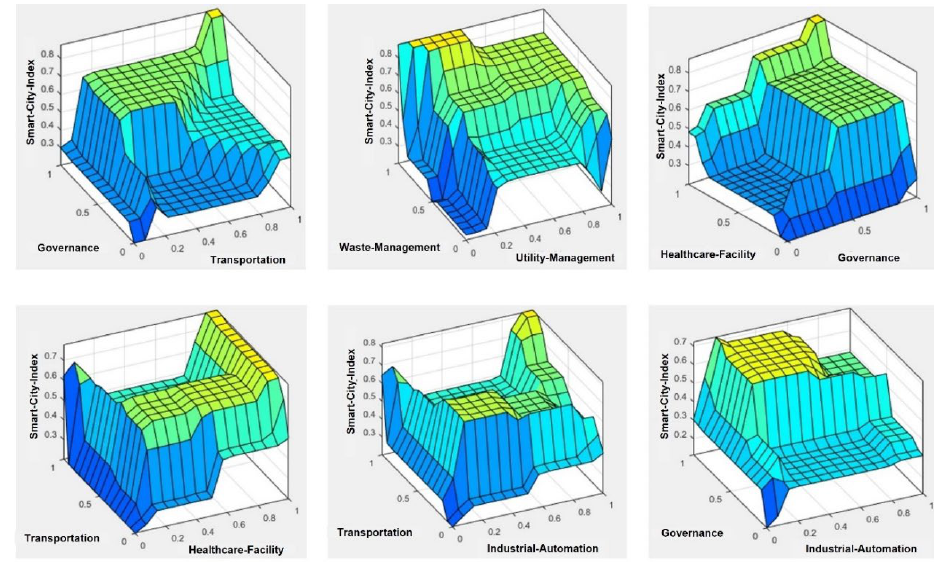
Figure 7. Surface view plot of smart city prediction scheme considering six key parameters.